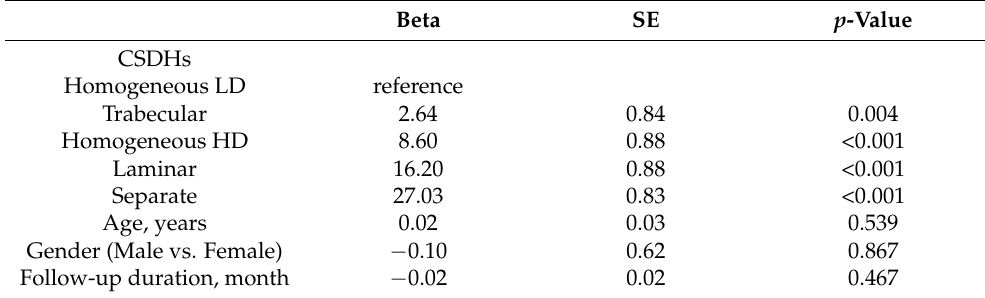
Table 4. The MHD among 5 types of CSDHs adjusted for age, sex, and follow-up duration. Beta